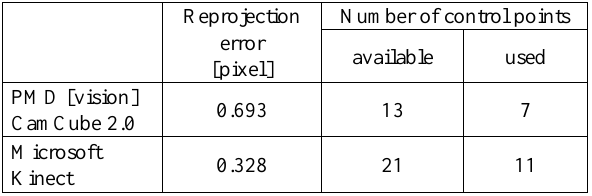
Table 1. Quantity and quality of the utilized control